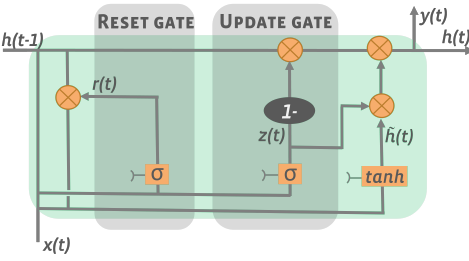
Figure 6. GRU architecture (adapted from